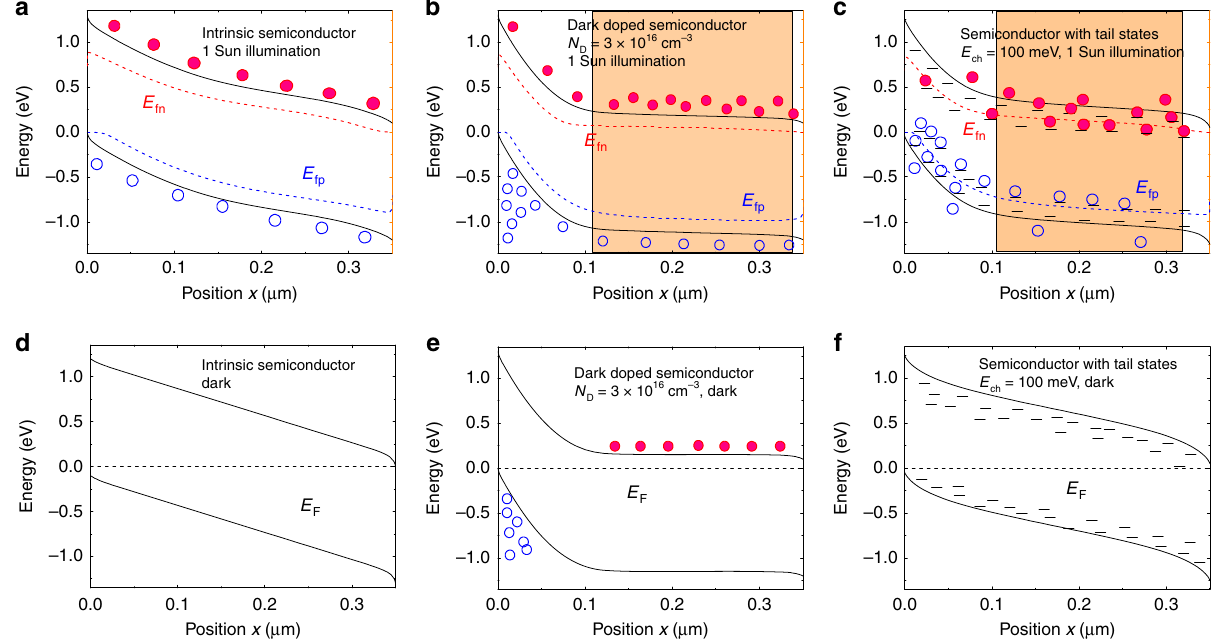
Fig. 4 Band diagram simulations under one sun irradiation and in the dark condition. Band diagram simulations of the photoactive layer: ( a ) shows the intrinsic semiconductor under one sun illumination and ( d ) shows the same photoactive layer under dark conditions; ( b ) shows the photoactive layer with an electron doping level of 3 × 10 16 cm − 3 and ( e ) shows the same semiconductor under dark conditions; ( c ) demonstrates the photoactive layer with tail states with a total tail state density of 2 × 10 17 cm − 3 and a tail state slope E ch equals to 100 meV under one sun illumination condition, the illumination is from the right side (cathode here) correlating to the inverted device structure as used in PCDTBT and DT-PDPP2T-TT devices; and ( f ) shows the same junction but under dark condition. For ( b ) and ( c ), the orange region indicates the low fi eld region in the junction where the collection ef fi ciency is poor. Simulation parameters are shown is Supplementary Table 1. Error bars are the standard deviation of a minimum of four different measurements of different sample